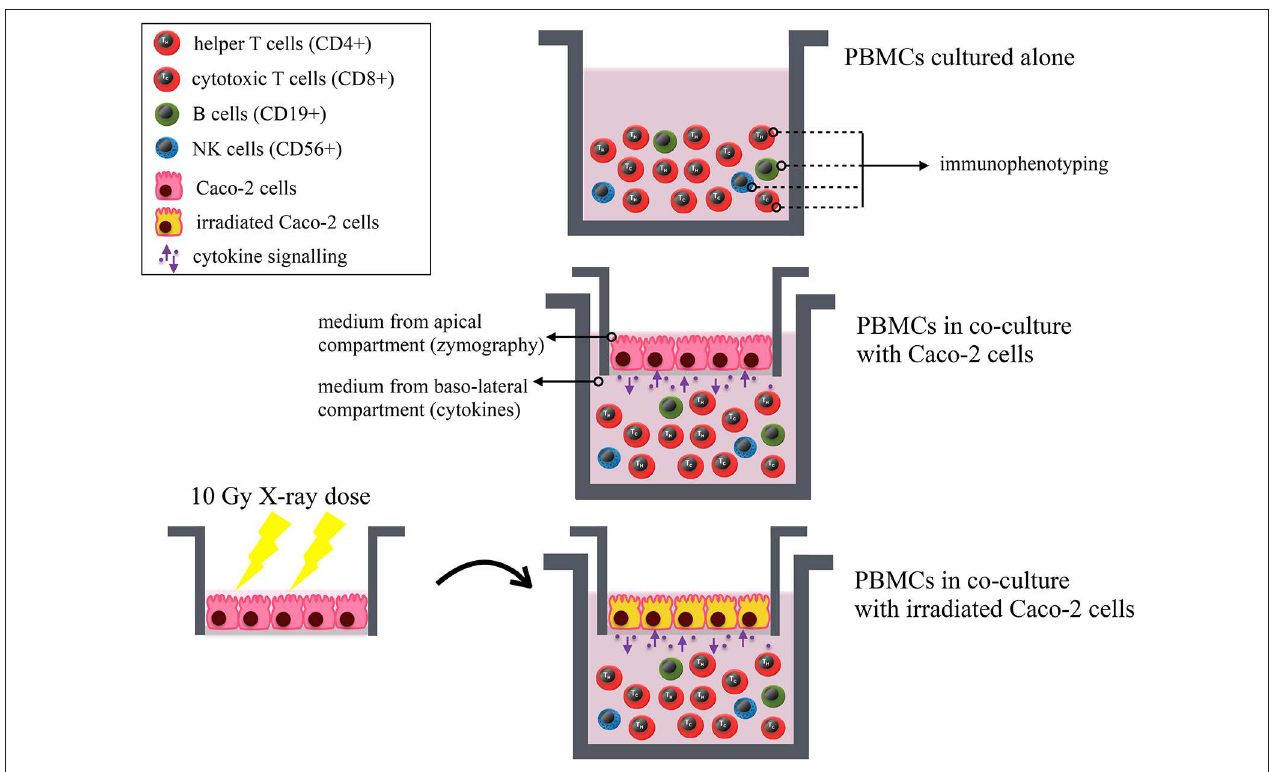
FIGURE 1 | Schematic illustration of all investigated experimental conditions. Results on immunophenotyping of PBMCs from healthy donors are obtained for: PBMCs cultured alone; PBMCs in co-culture with Caco-2 cells; PBMCs in co-culture with Caco-2 cells irradiated with a 10-Gy dose of X-rays. The following lymphocytic subsets are identified: helper (CD4 + ) and cytotoxic (CD8 + ) T cells, B lymphocytes (CD19 + ) and NK cells (CD56 + ). Preliminary zymography measurements and cytokine analysis ( Supplementary Material ) are performed from the culture medium from the apical and baso-lateral compartment of the co-culture, respectively. The MTT assay is also performed on both cell populations in all investigated conditions. All endpoints are studied as a function of